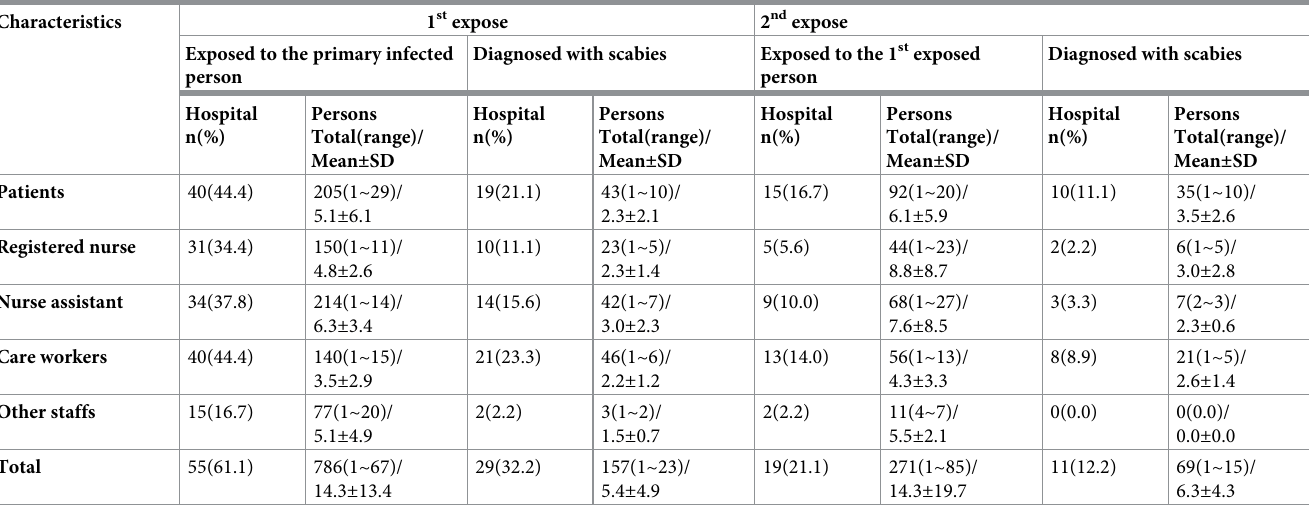
Table 7. Number of individuals infected after exposure to a patient with primary infection (N = 90).